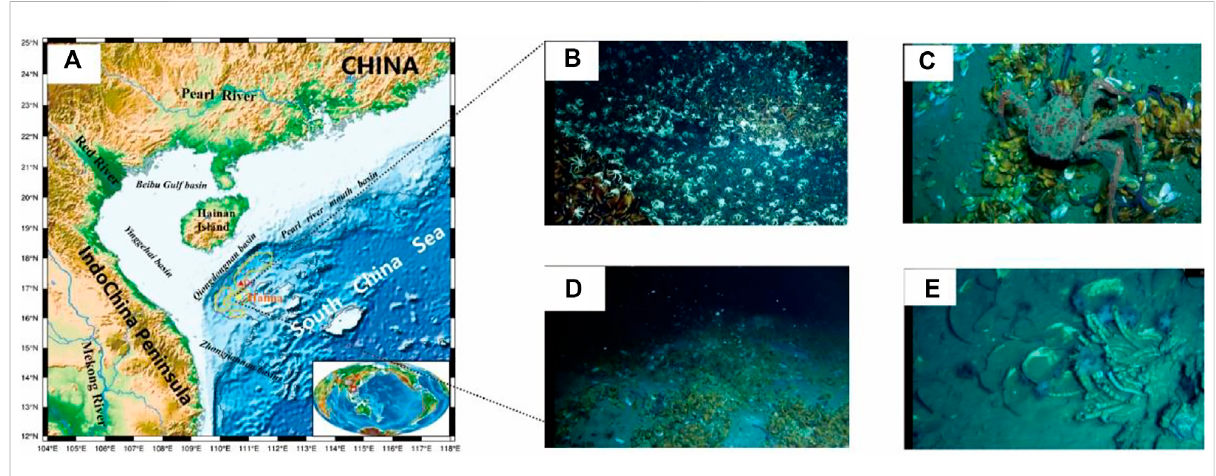
FIGURE 1 The methane seep area was observed in Qiongdongnan Basin. [ (A) : Study Area, (B – E) : Biological status of methane leakage